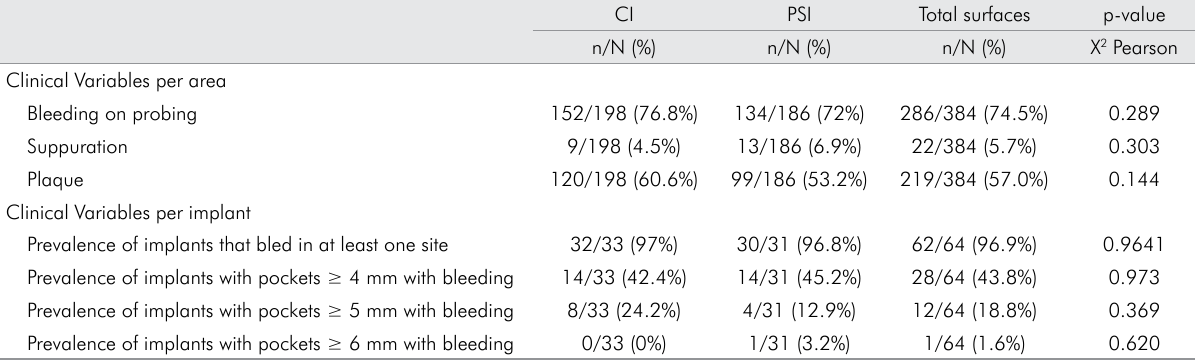
Table 2. Clinical parameters after 1 year of loading of conventional implants (CI) and platform switching implants (PSI).